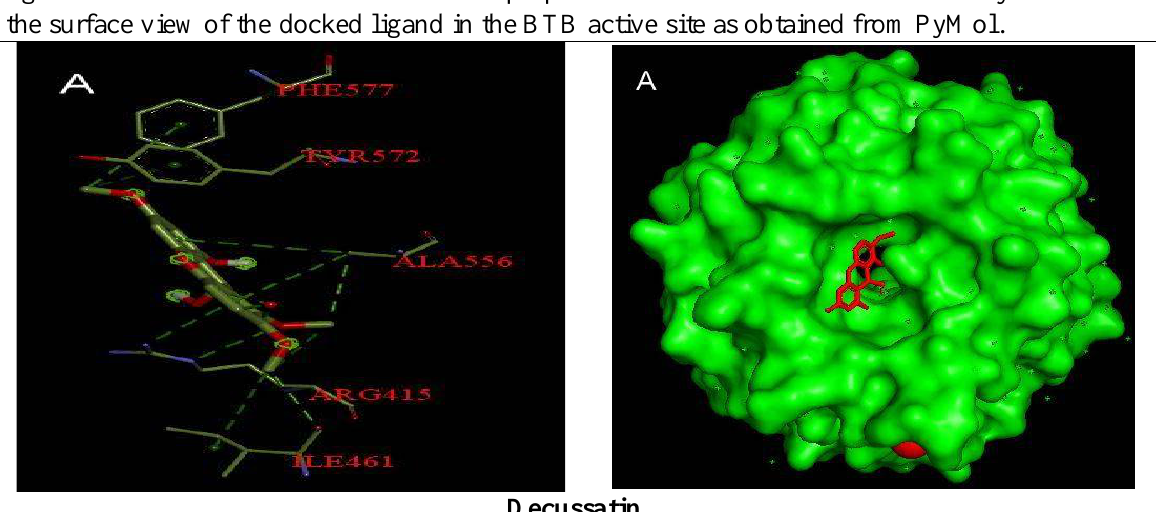
Figure S6: The three-dimensional illustrations of the interaction analysis of the individual ligands with the Kelch domain of the Keap1 protein as obtained from the Discovery studio and the surface view of the docked ligand in the BTB active site as obtained from